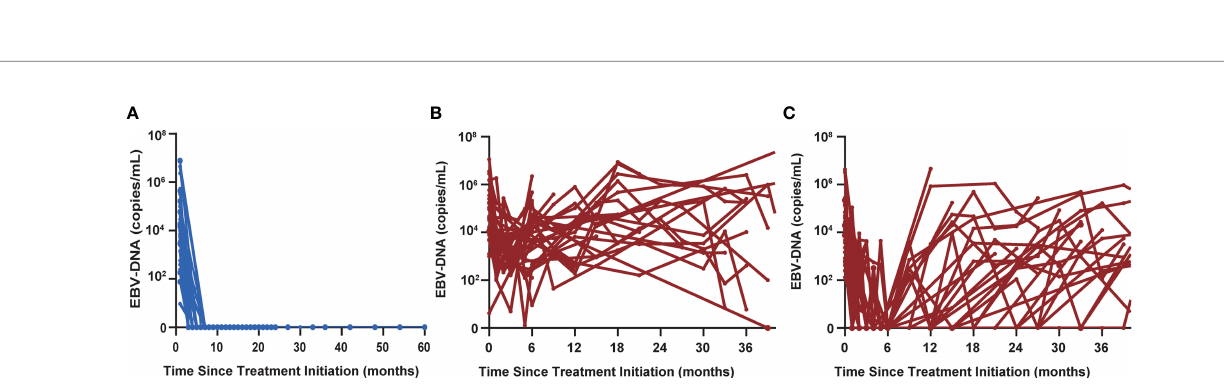
FIGURE 3 | (A) Thirty-nine of 105 patients had undetectable EBV-DNA levels at all posttreatment surveillance time points. (B) Thirty-three non-responders still had detectable EBV-DNA signal during posttreatment surveillance. (C) Thirty-three patients who initially had a biochemical complete response had a detectable EBV-DNA test during posttreatment